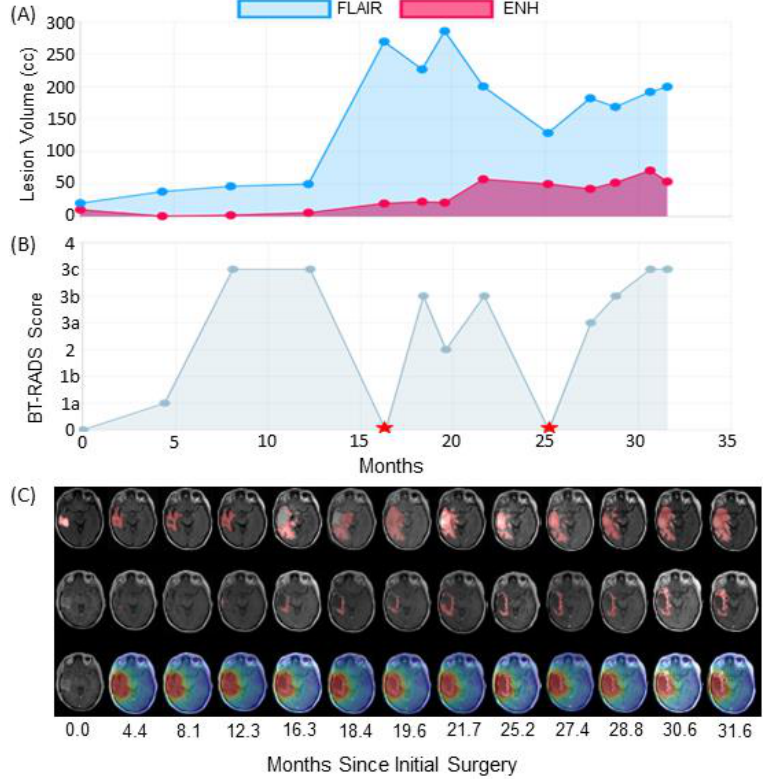
Figure 4. With our web platform, clinicians assessed ( A ) graphs of lesion volumes from FLAIR and T1w-CE (labeled ENH) imaging, as well as ( B ) A graph of Brain Tumor Reporting and Data System (BT-RADS) scores during a patient’s follow-up. The red stars indicate re-resection of suspected lesions. In this case, the patient had two re-resections (16.3 and 25.2 months) with significant treatment effect and necrosis found in both cases. ( C ) For each follow-up visit in the above graph, the FLAIR MRIs (top